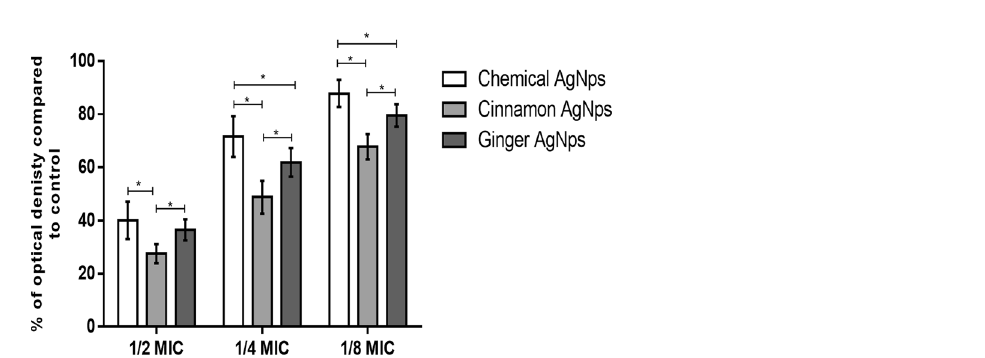
Figure 8. A comparative analysis of % of optical density of formed biofilm against different concentrations of cinnamon AgNPs, ginger AgNPs, and chemical AgNPs using two-way ANOVA test (Data are presented as mean ± SD, n = 23, p -value (*) <